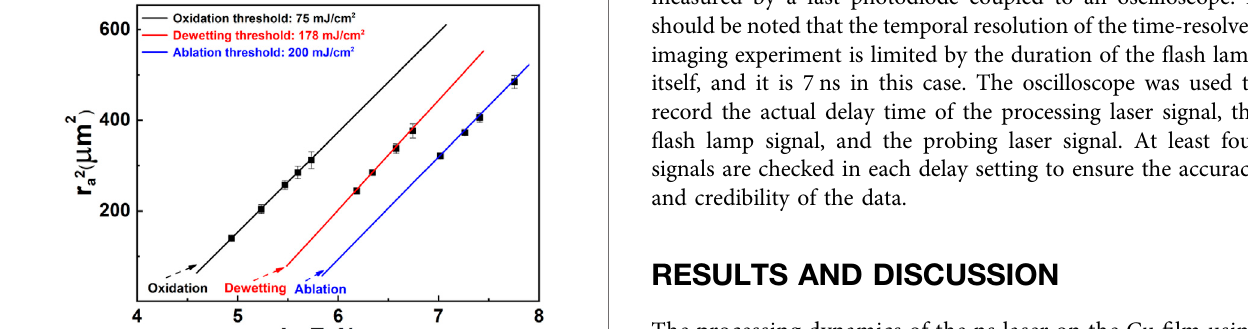
Frontiers in Physics |